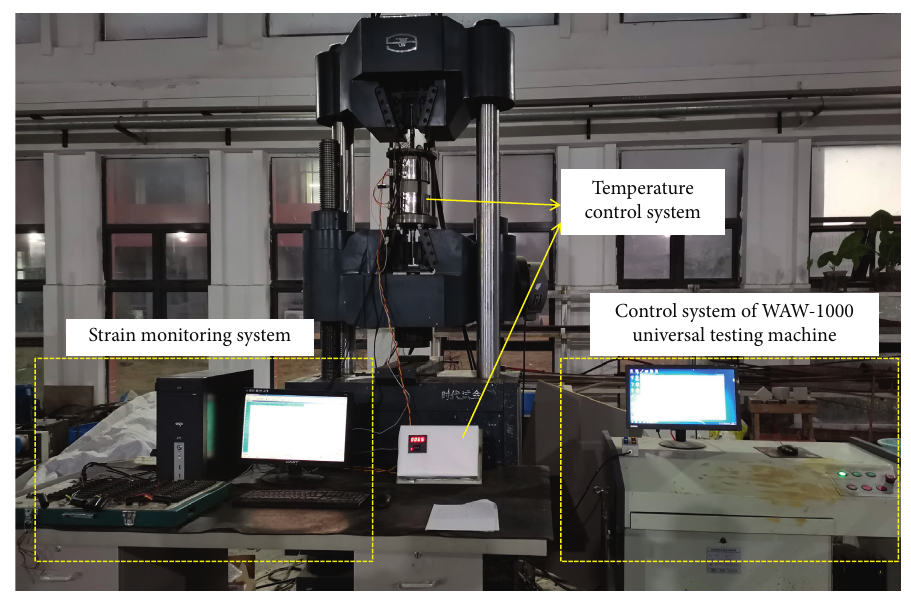
Figure 6: Pull-out test system of bolt.